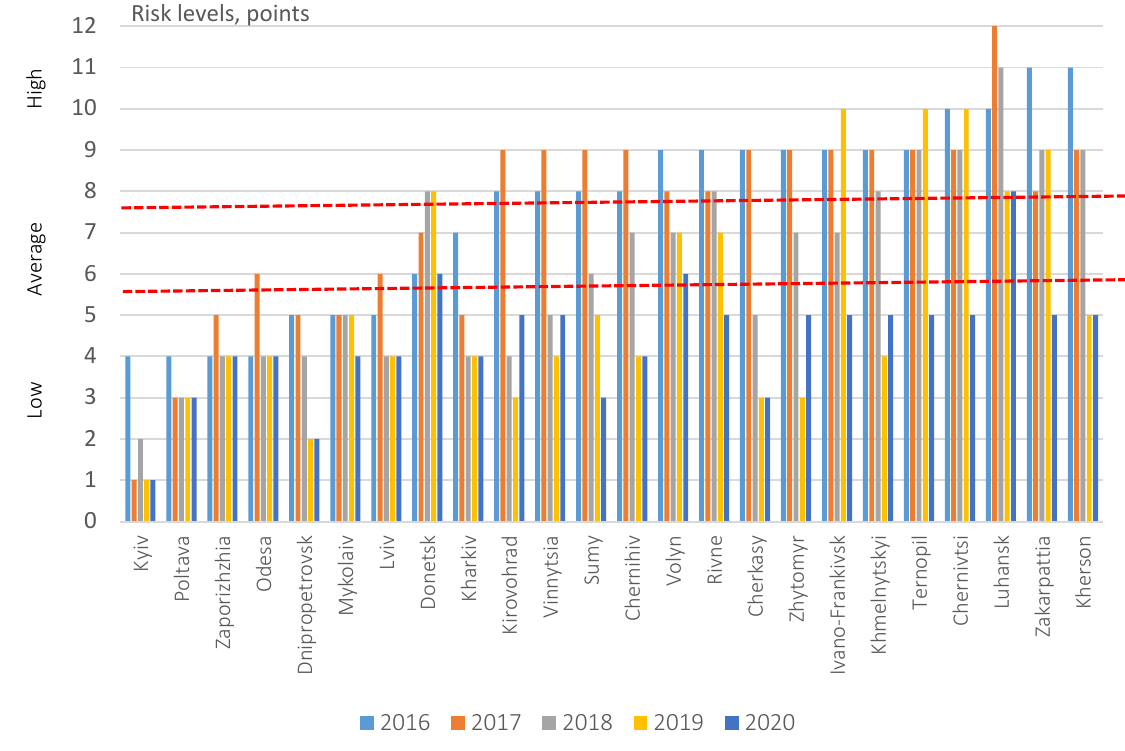
Figure 2. Budget risks of the regions of Ukraine,